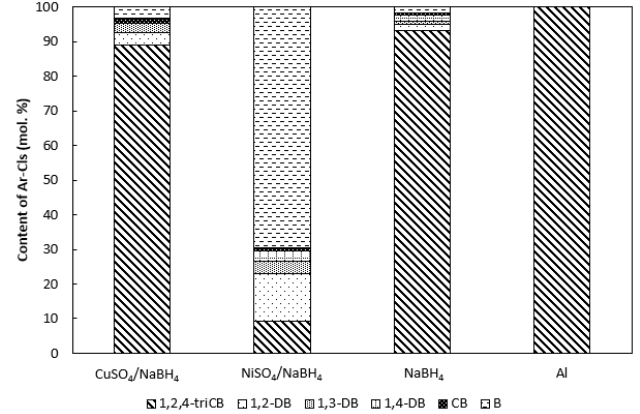
Figure 9. The composition of reaction mixture at the end of HDC of 1,2,4-trichlorobenzene using in situ generated Cu (CuSO 4 /NaBH 4 ), Ni (using NiSO 4 /NaBH 4 ) and comparison of action of the sole NaBH 4 (for more details see Supplementary Materials, Table S2). The experimental details are described in Sections 4.2.2 and 4.2.3.